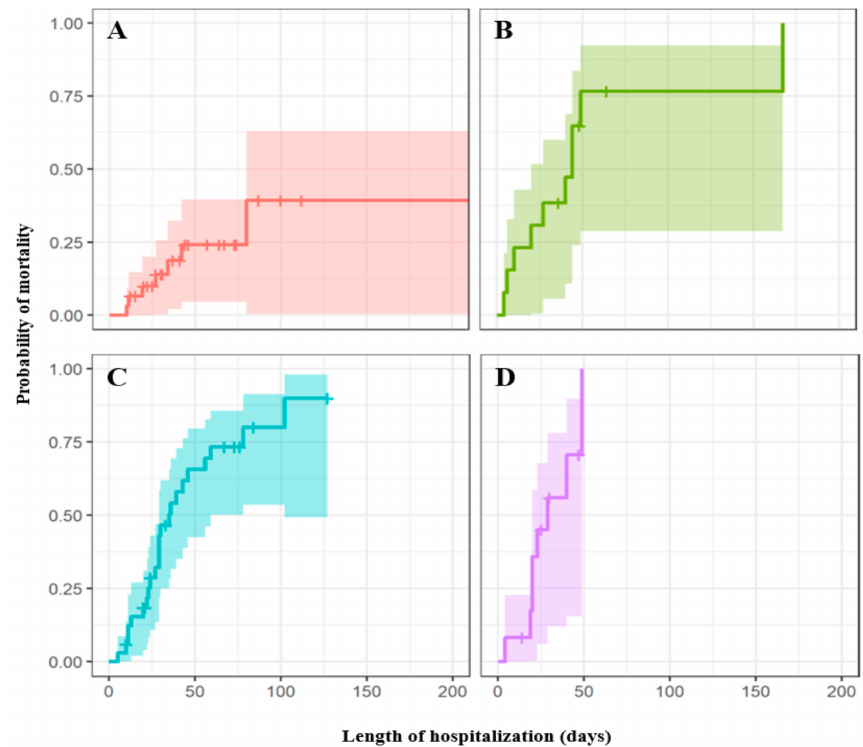
Figure 4. Kaplan–Meier survival curve that shows the relative probability of mortality based on Chinese ethnicity and diabetes mellitus (DM). ( A – D ) Patients are neither Chinese nor with DM ( A ), Chinese without DM ( B ), Non-Chinese with DM ( C ) and Chinese with DM ( D ), respectively. In the second model (Table 3), risk factors for mortality were analysed again among patients infected with CRAB, with antibiotic data being included in the analysis. Variables including comorbidity (diabetes mellitus, malignancy, kidney disease, cardiovascular disease, brain and neurological disorder, blood and immune disease) and prescription of carbapenem as empiric treatment were found to be significant. Multivariate analysis showed that the presence of comorbidities significantly increases the mortality rate of patients who have CRAB infection. Table 3. Cox proportional hazard model for in-hospital all-cause mortality associated with CRAB infection ( n = 57).